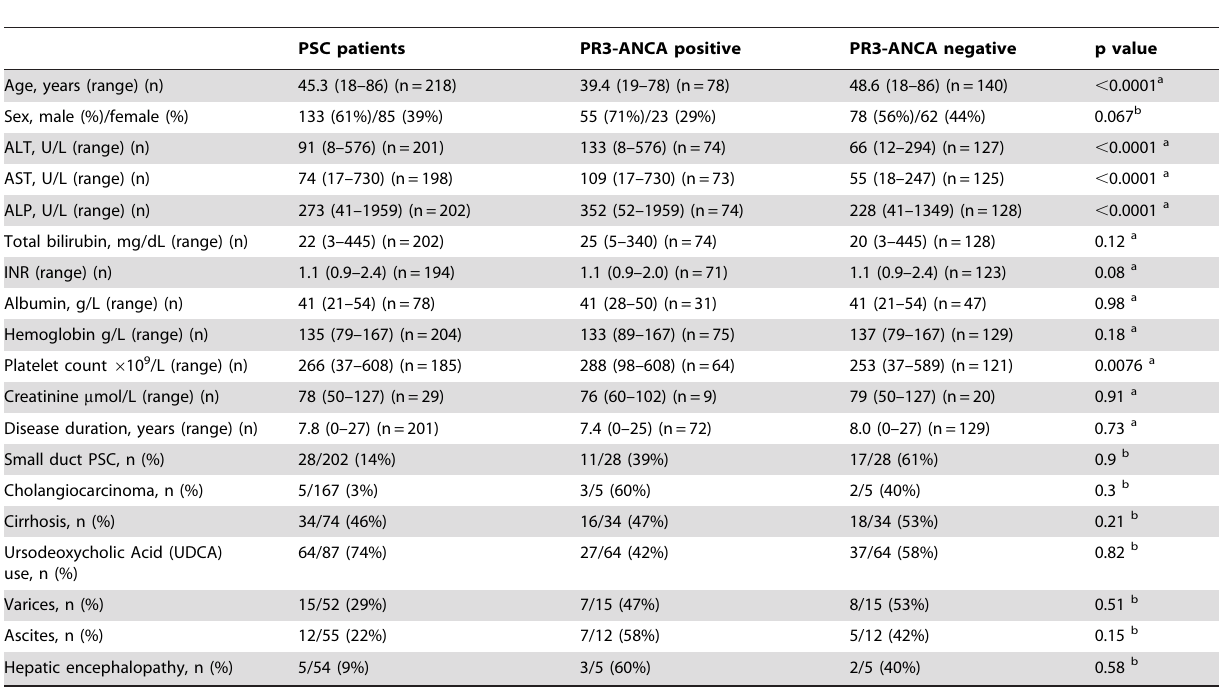
Table 3. Comparison of the clinical parameters of PSC patients at the time of serum testing according to the PR3-ANCA status as measured by chemiluminescence immunoassay (CIA).